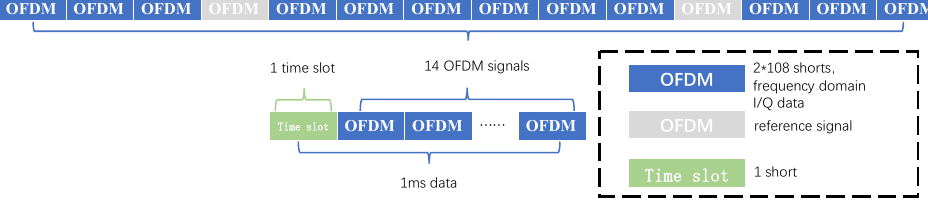
Figure 3. OFDM signal